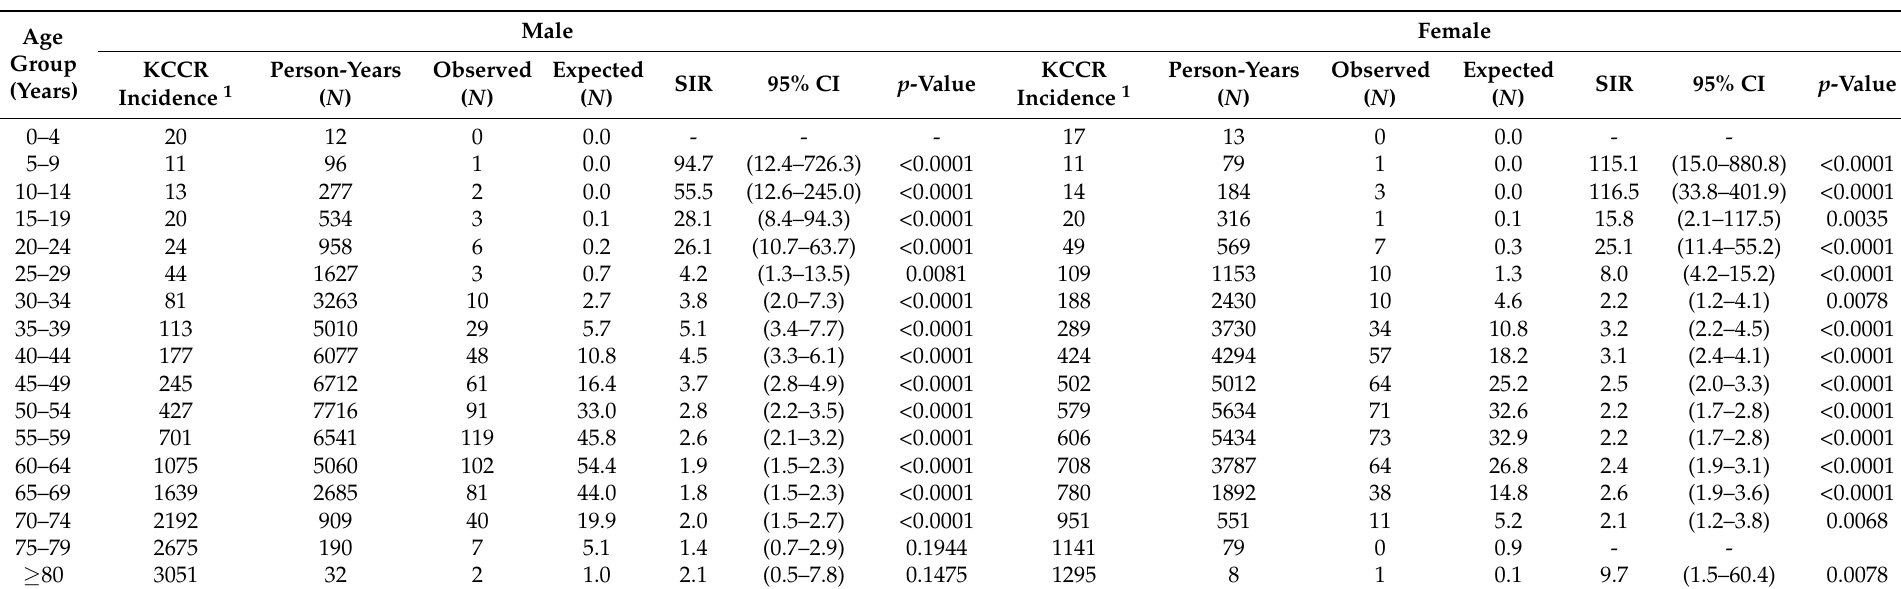
Table 1. Age-adjusted standardized incidence ratio of all de novo primary cancers after kidney transplantation during 16